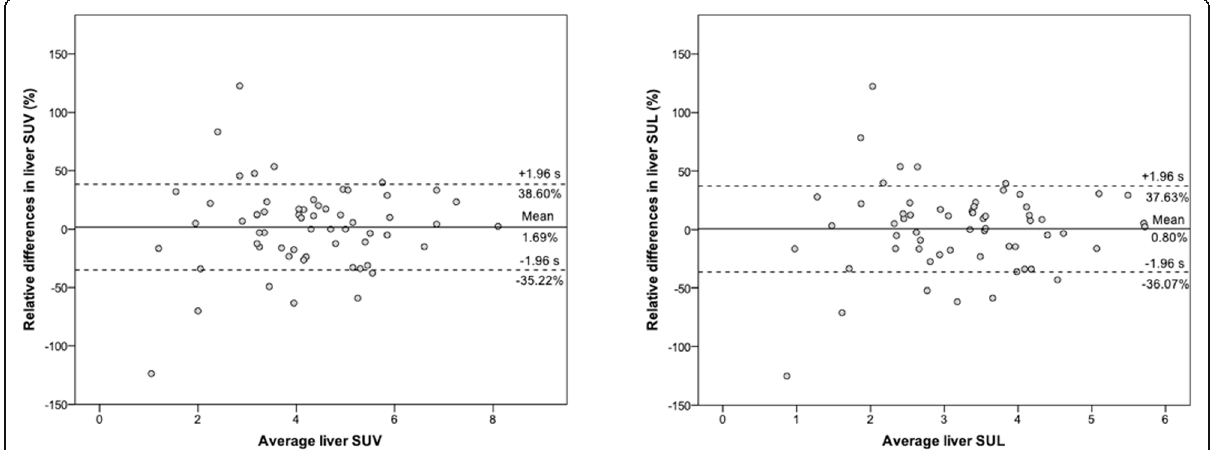
Fig. 2 Bland-Altman plots of baseline and follow-up 68 Ga-PSMA11 PET/CTs agreement for both liver SUV and